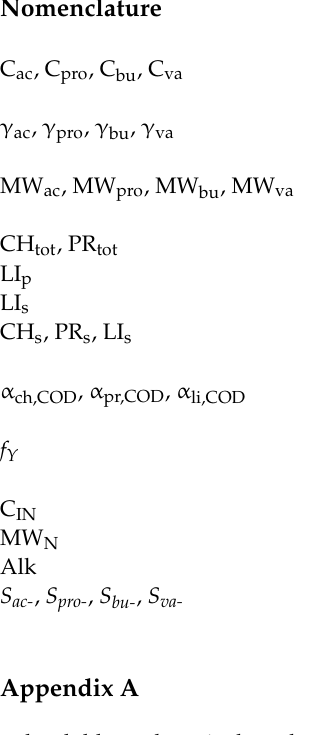
Table A1. Computation of total, soluble, and particulate, degradable and undegradable COD fractions from